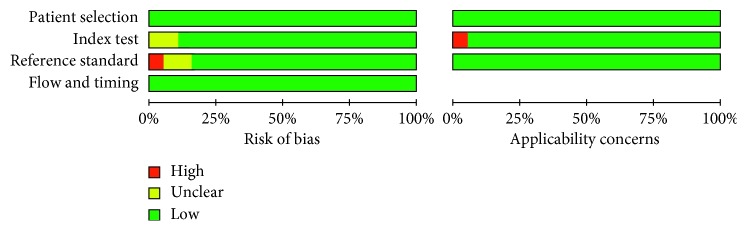
Assessment of methodological quality domains in all the studies. Proportions of studies rated as “high,” “unclear,” and “low” are presented.